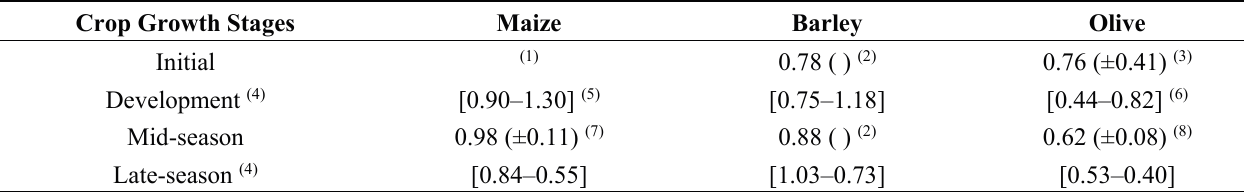
Table 8. Average and standard error of the mean or the range of actual crop coefficients estimated with vegetation indices approach (K c VI ) for the various crop growth stages of each